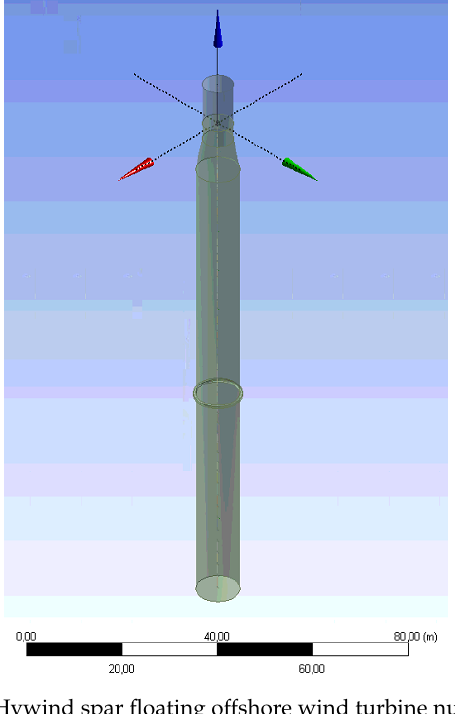
Figure 2. OC3-Hywind spar floating offshore wind turbine numerical model. Table 3. Main characteristics of the UMaine-Hywind structural model implemented in